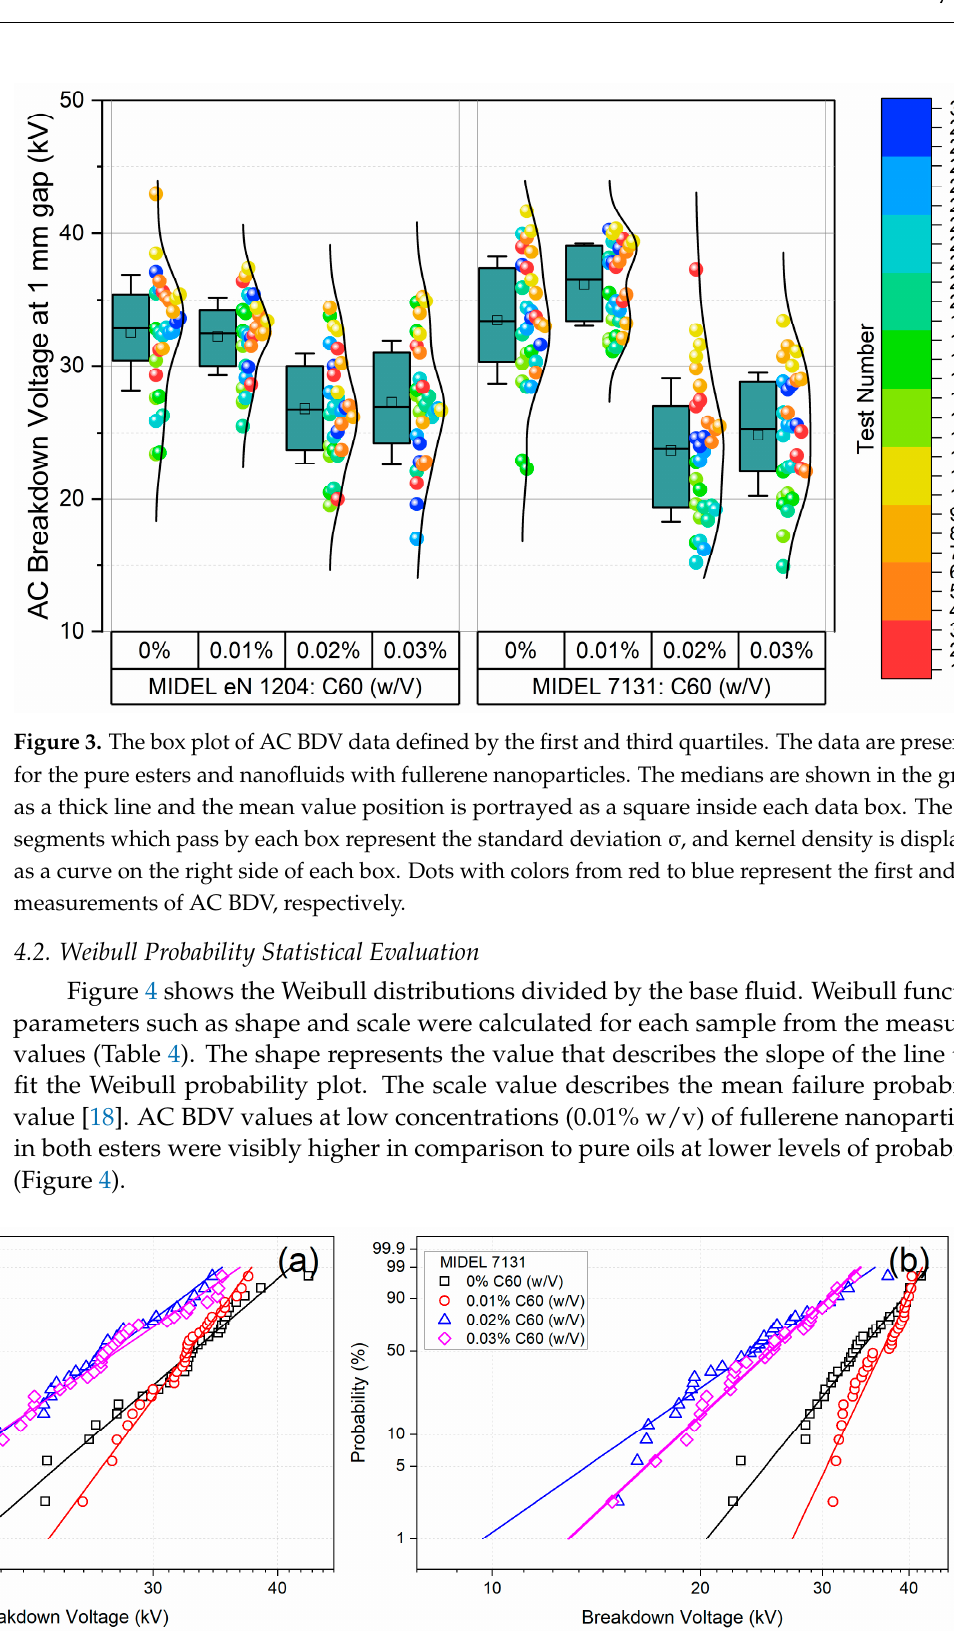
Figure 4. Weibull distribution graphs showing the particular breakdown probabilities. Colored points represent the measured data, and the thick lines show the fits to the theoretical distribution (estimated at significance alpha 0.05) given by formula (1). The graphs are presented as semi-log graphs, and therefore the fitted lines appear as straight lines. ( a ) NE-based nanofluids and pure NE, ( b ) SE-based nanofluids and pure SE.